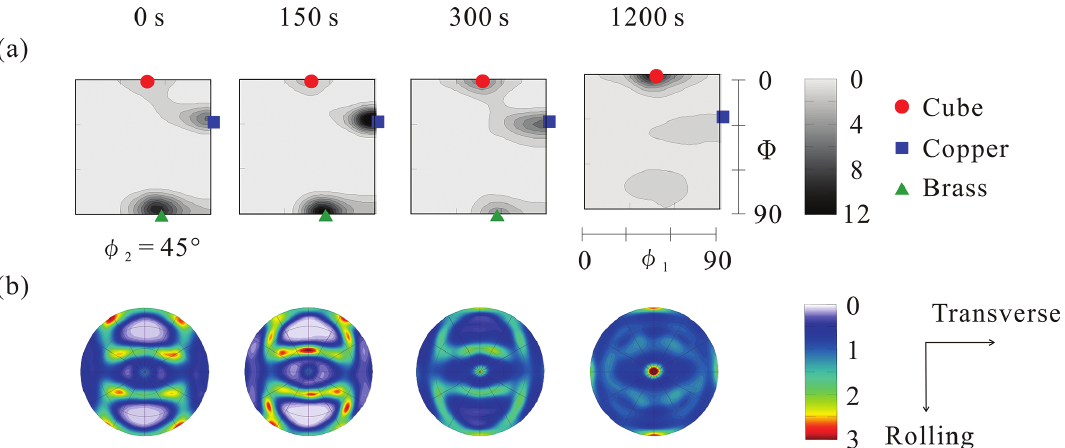
Figure 11: (a) ODFs in φ 2 ¼ 45° section and (b) {100} complete pole figures of the annealed 75% cold-rolled copper sheets at 473 K for different holding times. The directions of the texture and non-texture components in the pole figures are described in Figure 6.